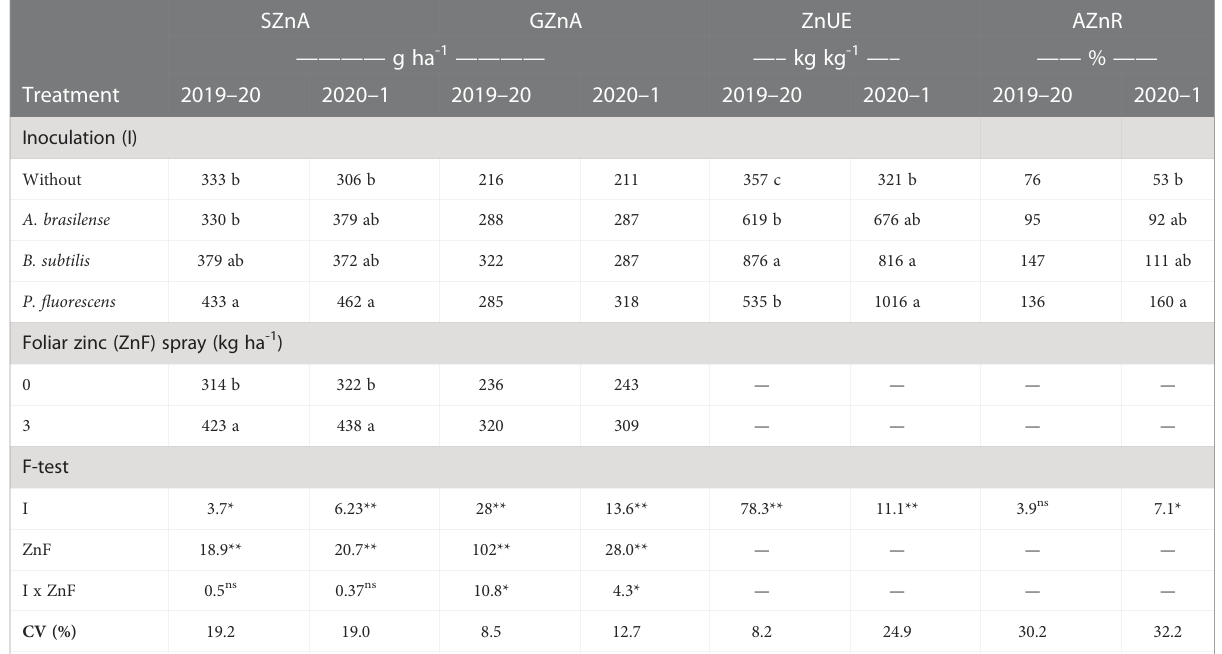
(Table 5; Figure 5A). Inoculation with B. subtilis and foliar